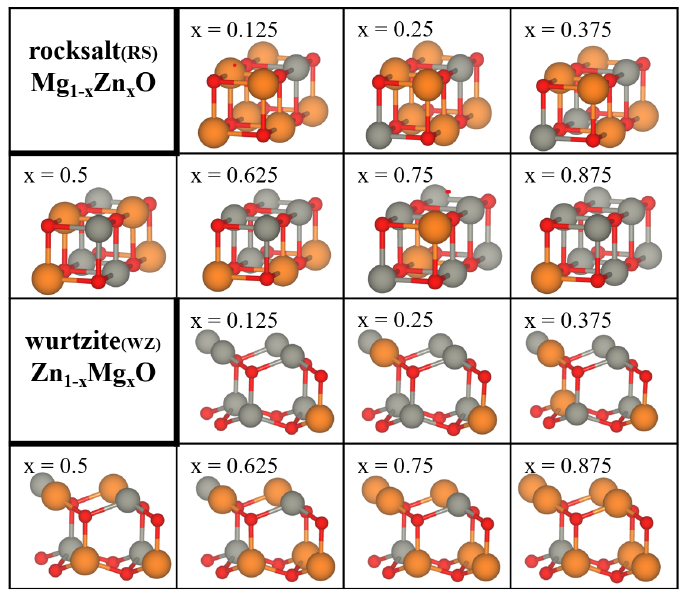
Figure 1. Supercells of 2 × 1 × 1 rocksalt Mg 1 − x Zn x O and 2 × 2 × 1 wurtzite Zn 1 − x Mg x O. The concentration (x) of substituted atoms for each of the two ZMO models increases from 0.125 to 0.875. Orange, red and gray spheres represent Mg, O and Zn atoms,